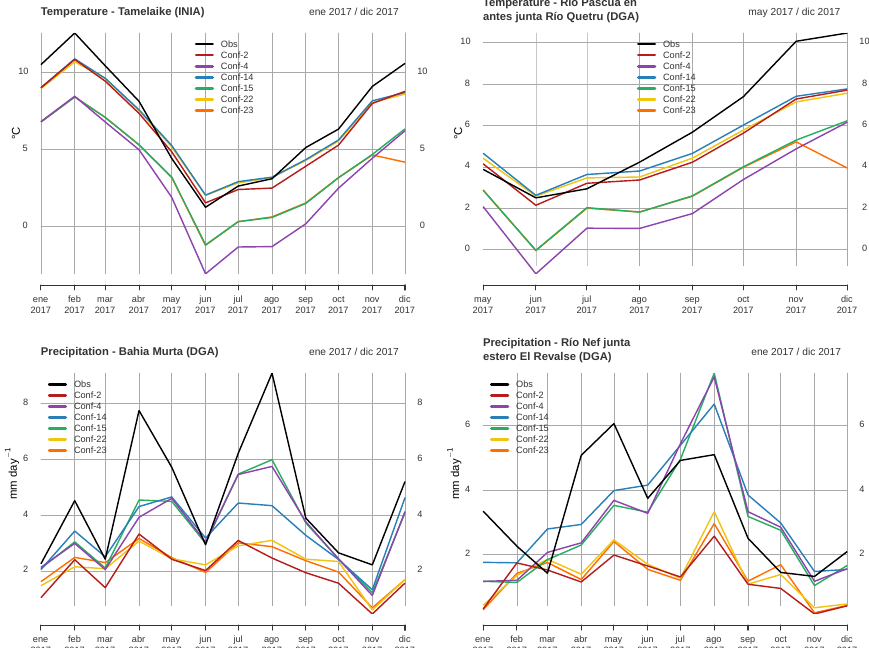
Figure 11. Top: examples of monthly mean Temperature time series between observed values (obs) and best ranked configurations (14, 2 and 22) and worsts (15, 4, and 23). Bottom: examples of monthly precipitation time series between observed values (obs) and three best ranked configurations (9, 10, and 13) and worsts (8, 19, and 20).